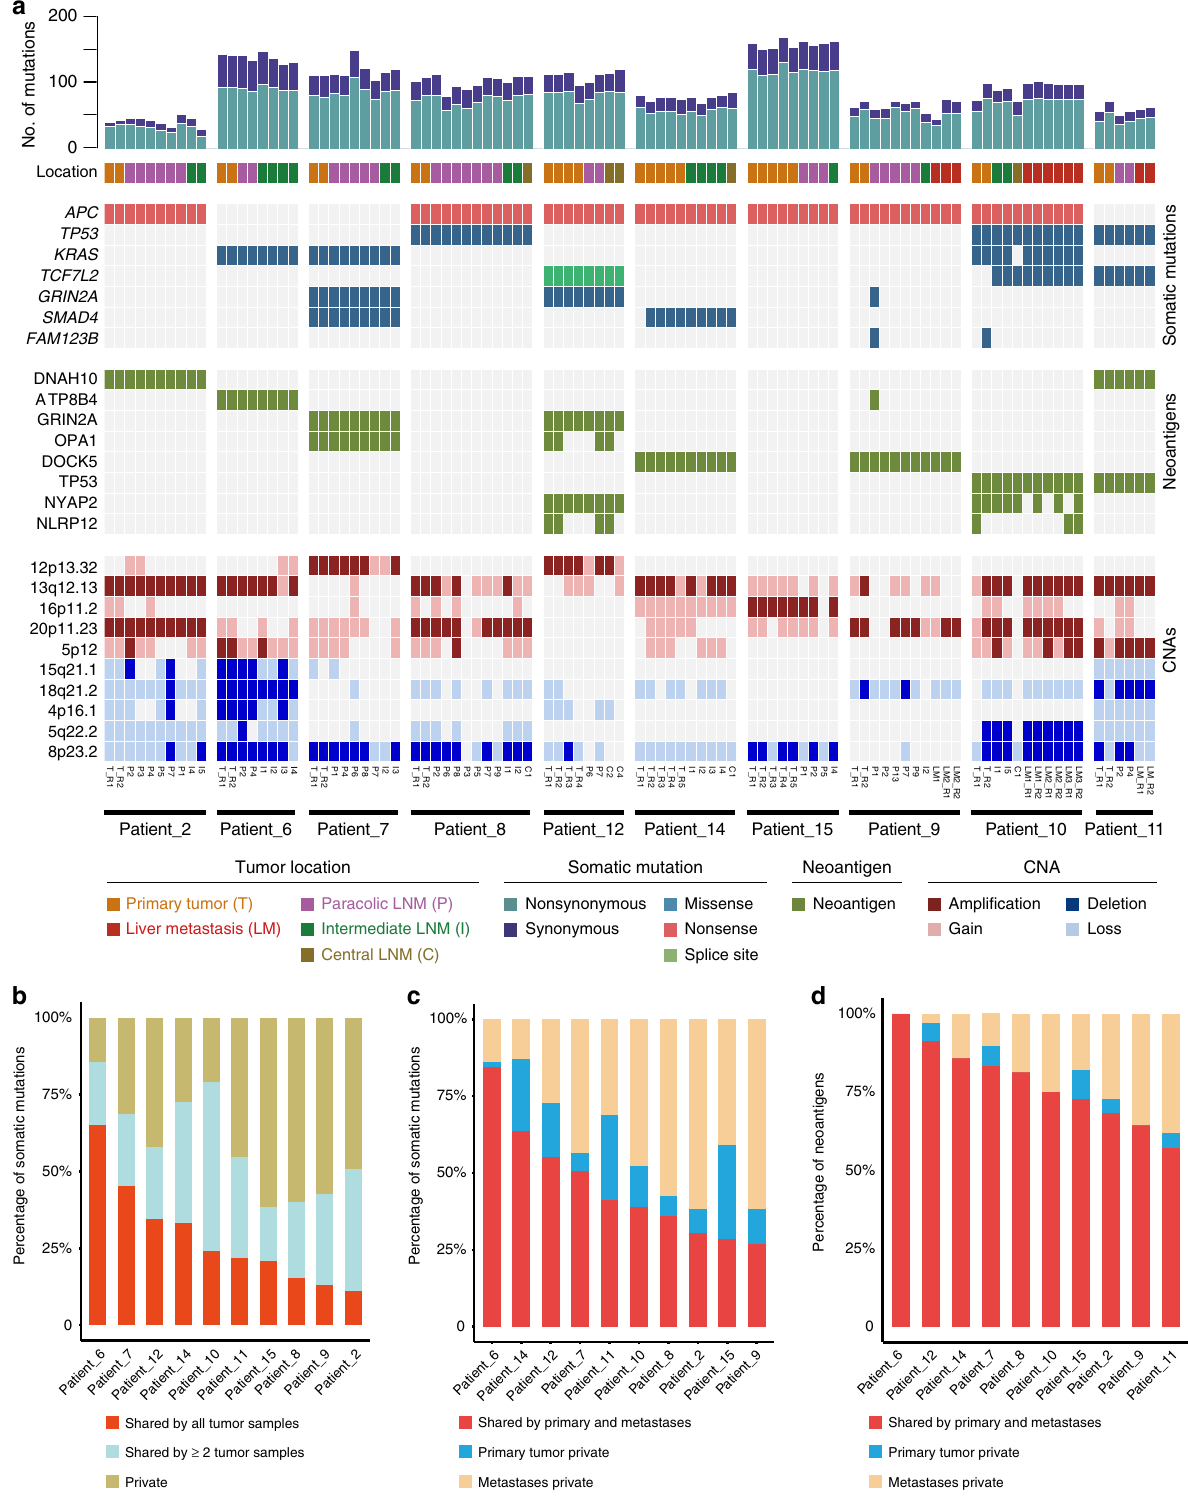
Fig. 2 Genomic landscape of 10 CRC patients. a The top panel shows the number of mutations identi fi ed in each tumor sample. The spatial location of each tumor sample is denoted below. The second panel details seven recurrent driver genes (mutated in ≥ 2 patients) with the mutation type indicated. The third panel details recurrent genes associated with putative neoantigens. The bottom panel shows recurrent CNAs: dark red for ampli fi cations (CN ≥ 4), light red for gains (2 < CN < 4), dark blue for deletions (CN = 0), and light blue for losses (0 < CN < 2). b Percentage of mutations shared by all the tumor samples, two or more tumor samples, and private to only one tumor sample in each patient, respectively. c Somatic mutations and d Neoantigens shared between the primary tumors and